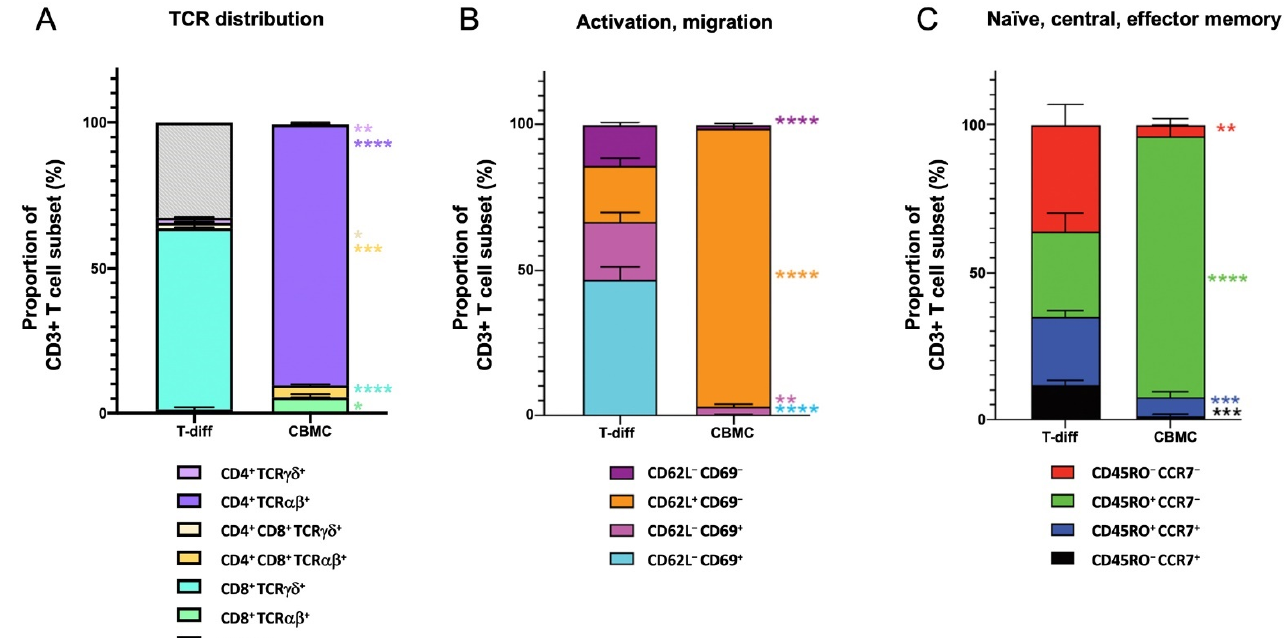
Figure 4. HSC-derived T cells express unique CD3 + profile subsets. Phenotypic profiles of T cells differentiated from UCB-derived HSCs (T-diff) were compared to naturally occurring, thymic-derived T cells directly obtained from UCBs. ( A ) Represents the distribution of TCR αβ and TCR γδ expressed on CD4 + , CD8 + , and CD4 + CD8 + T cells (all CD3 + ). CD3 + cells which did not express a complete repertoire of T cell markers were classed as ‘Other’. ( B ) Represents the activation state of CD3 + T cells characterized by expression of CD69 and migratory potential by CD62L. ( C ) Characterizes the proportion of CD3 + T cells that share markers indicative of naive, central memory and effector memory phenotypes; Naive T cells were defined by CD45RO − CCR7 + , effector T cells by CD45RO − CCR7 − , effector memory T cells by CD45RO + CCR7 − and central memory T cells by CD45RO + CCR7 + . Dead cells, doublets and debris were excluded by flow cytometric analysis, prior to gating viable, CD7 + CD3 + cells into each T cell subset. Bars indicate mean % of CD3 + subset ± SEM of at least 4 independent biological samples, where significant differences between the proportion of T cell subsets in T-diff samples are compared to CBMC T cells * p ≤ 0.05, ** p ≤ 0.01 *** p ≤ 0.001 **** p ≤ 0.0001. Colors represent individual cell subsets as indicated. Abbreviations: CBMC, cord blood mononuclear cells; CCR7, C-C chemokine receptor type 7; TCR, T cell receptor; T-diff, T cells differentiated from UCB-derived HSCs.